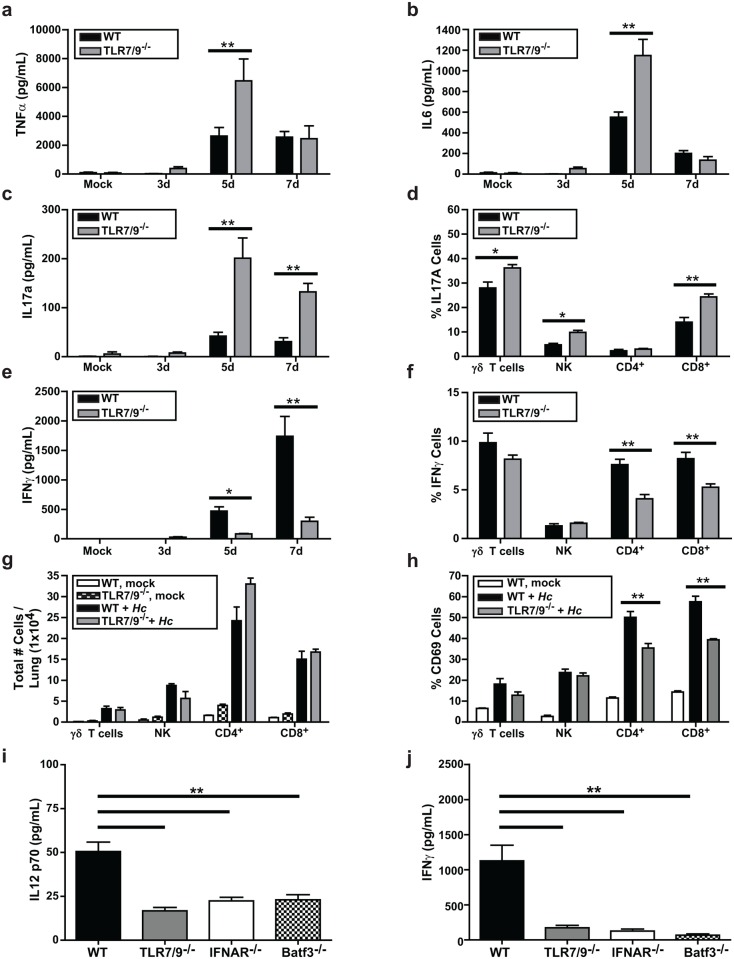
TLR7/9 is required to stimulate optimal levels of IFNγ and restrict IL17 production.Lungs of mock-infected or infected wild-type and TLR7/9-/- mice were harvested, homogenized, and evaluated for cytokine levels (A) TNFα, (B) IL6, (C) IL17a, and (E) IFN-γ. (D, F-H) Intracellular cytokine staining on lung cells was measured to detect IFN-γ and IL17A production in γδ T cells, NK cells, CD4+ and CD8+ T cells isolated from the lung. Cells were defined as: CD4+ T cells (CD45+CD3ε+CD4+), CD8+ T cells (CD45+CD3ε+CD8+), γδ T cells (CD45+CD3ε+γδTCR+), NK cells (CD45+CD3ε-NK1.1+). (G) Total number of T cells per lung and (H) the percentage of T cells that were CD69+ were calculated. (I-J) WT, TLR7/9-/-, IFNAR-/-, and Batf3-/- mice were either mock-infected or infected with 3x105
Histoplasma yeasts. Lungs were harvested, homogenized, and evaluated for levels of (I) IL12 p70 and (J) IFNγ. All error bars indicate SD. *p < 0.05; **p < 0.001; p values were determined by ANOVA.